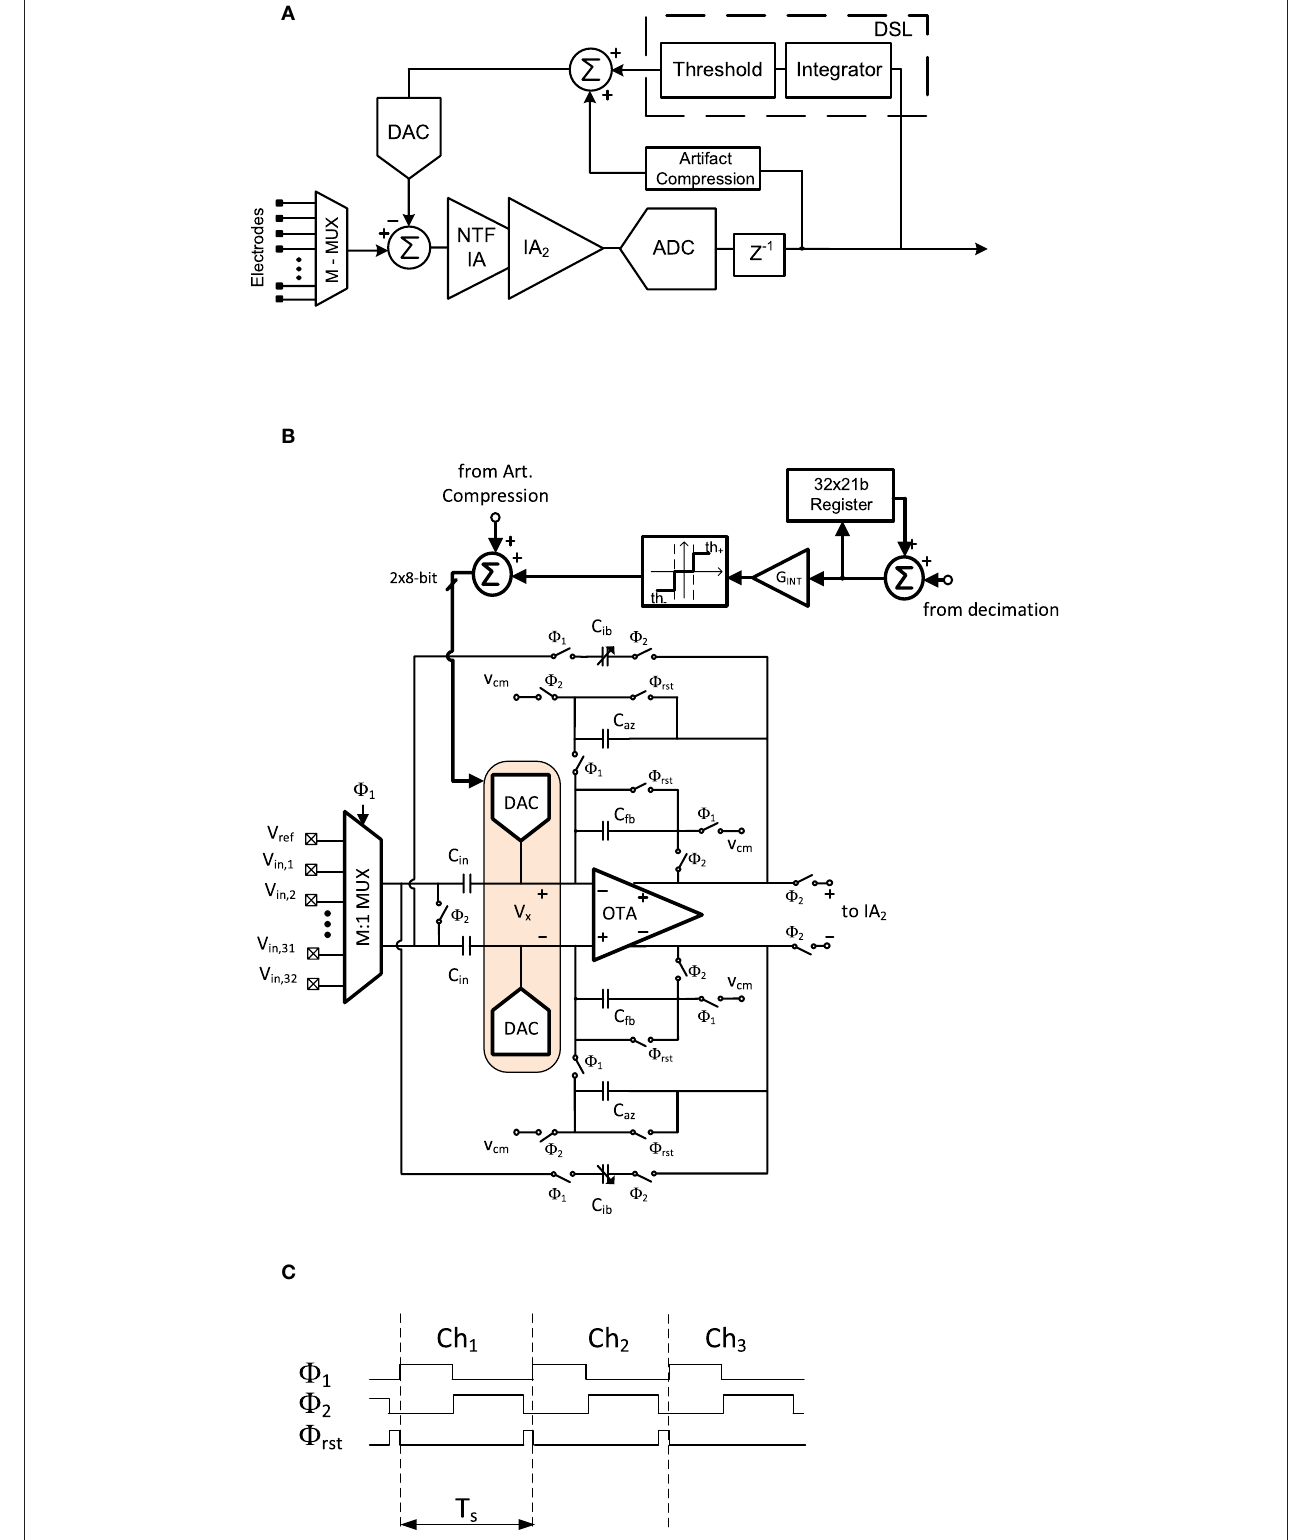
FIGURE 13 | TDM AFE proposed in Pérez-Prieto et al. (2019). (A) Block diagram. (B) Simplified schematic of CDS amplifier. (C) Simplified timing diagram of CDS amplifier.